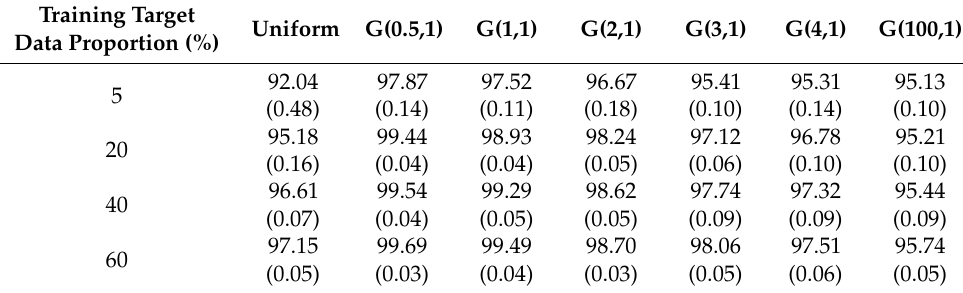
Table 10. Comparison of models for different ratios of training